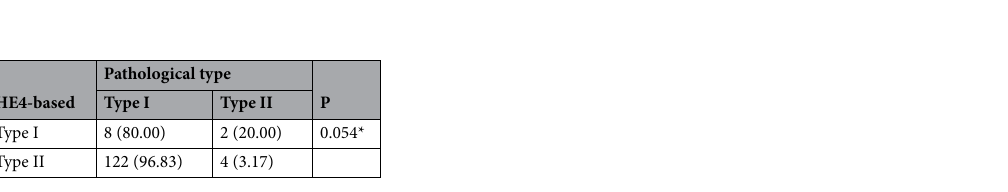
Table 7. The area under the ROC curve (AUC), optimal critical value, sensitivity and specificity of HE4 for different pathological types of EC.